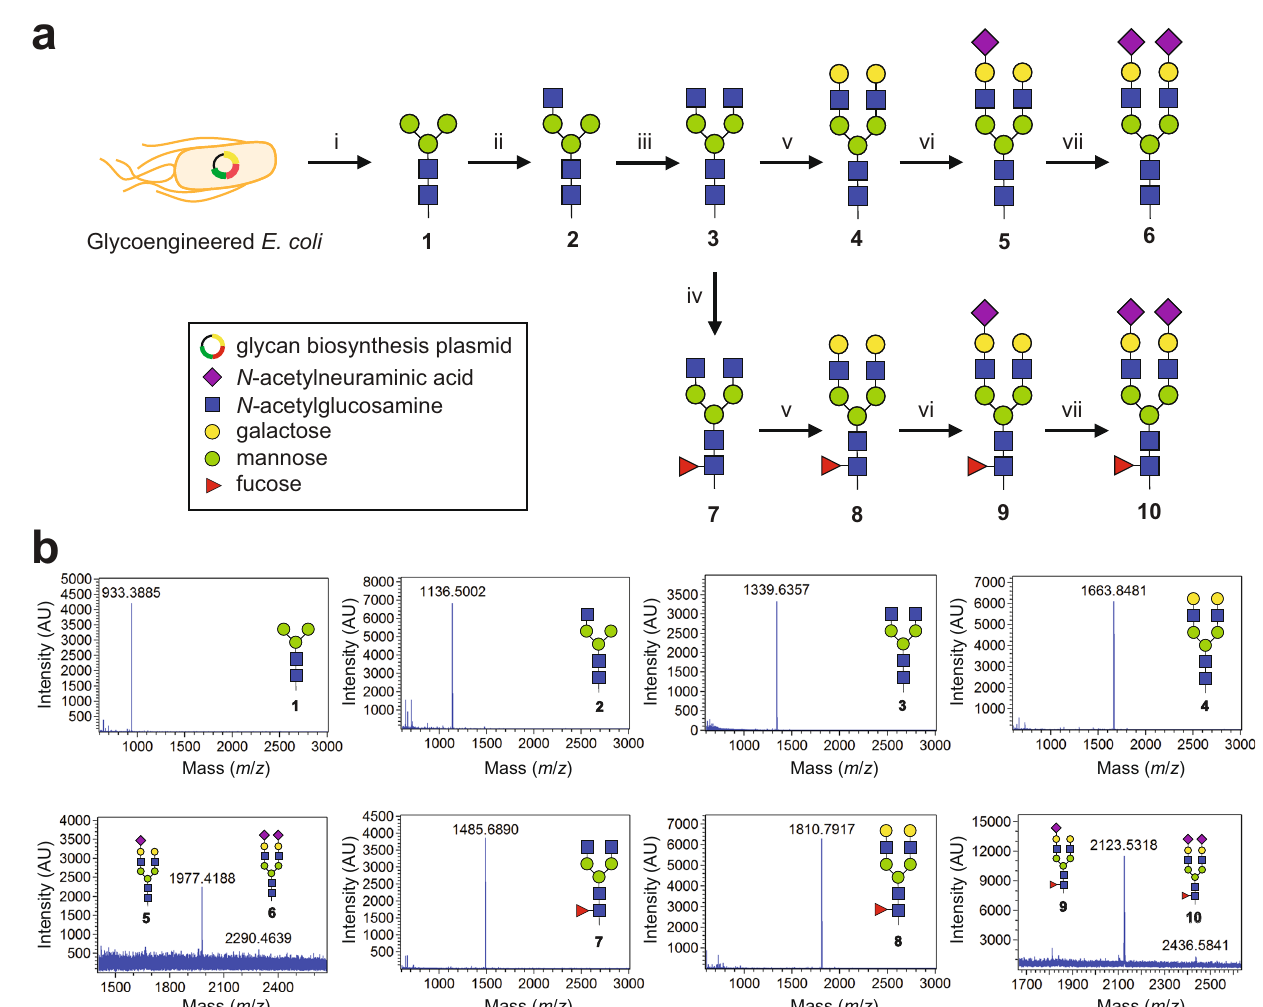
Fig. 4 | Cell-free construction of hybrid- and complex-type N -glycans using Sx- GTs. a Schematic of bioenzymatic routes to hybrid- and complex-type N- glycan structures.Man 3 GlcNAc 2 glycan(M3;glycan1)derivedfromglycoengineered E.coli cellsequippedwithbiosynthesispathwayforeukaryotictrimannosylcore N -glycan wasusedasprimerforglycanconstruction.Subsequentcell-freeglycanelaboration reactionsyieldedthefollowing N -glycanstructures:2G0-GlcNAc;3G0;4G2;5G2S; 6 G2S2; 7 G0F; 8 G2F; 9 G2S1F; and 10 G2S2F. Glycan naming follows